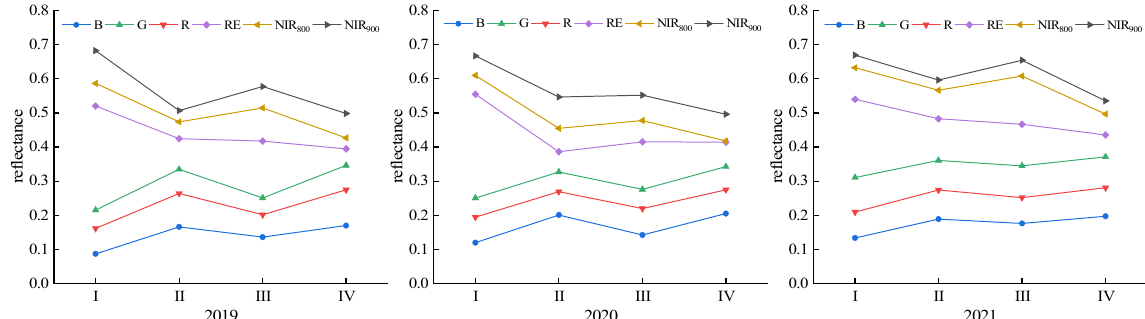
Figure 4. Variations in the canopy reflectance at different grape growth stages ( Ⅰ , Ⅱ , Ⅲ and Ⅳ represent the new shoot growth stage, flowering stage, fruit expansion stage and veraison and maturity stage, respectively).